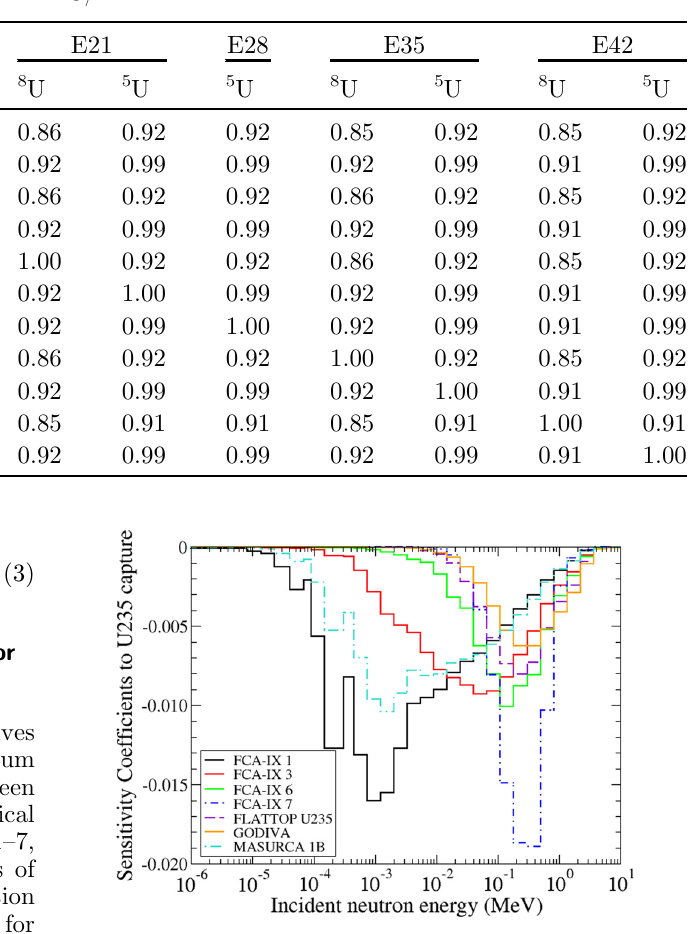
Fig. 2. 33-group sensitivity pro fi les of several critical masses to 235 U